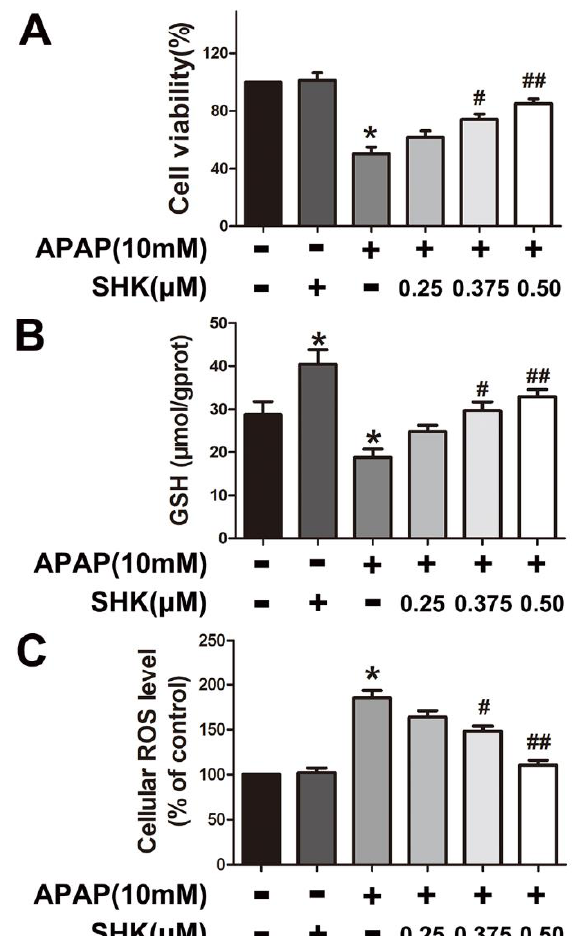
Figure 3. Effects of SHK on cell viability and oxidative stress in L-02 cells. ( A ) L-02 cells were treated with increasing concentrations of SHK (0.25, 0.375 and 0.50 μM) for 1 h, then use APAP (10 mM), cultured for 24 h, and then cell viability was evaluated by MTT assay. ( B , C ) L-02 cells were treated with SHK for 1 h, then treated with APAP (10 mM) and cultured for 8 h together, and then GSH and ROS was assessed using a commercial GSH test kit and 2houghdichlorofluorescin diacetate (DCF-DA) fluorescence assay, respectively. All of the data represent the average from three independent experiments. * p < 0.05 versus the control group; # p < 0.05 and ## p < 0.01 versus the APAP group.